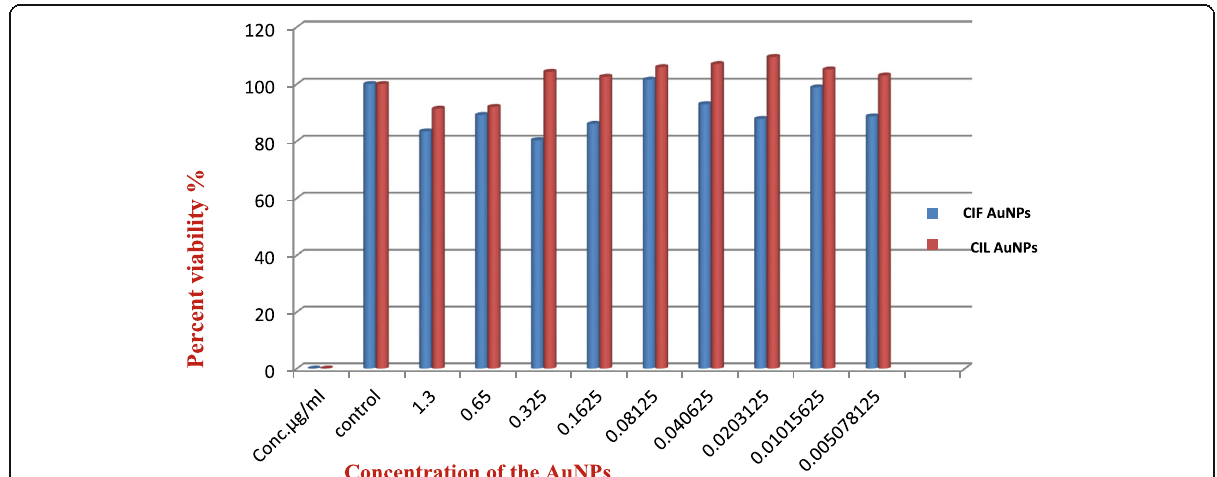
Fig. 9 Percent viability in treated VERO cell